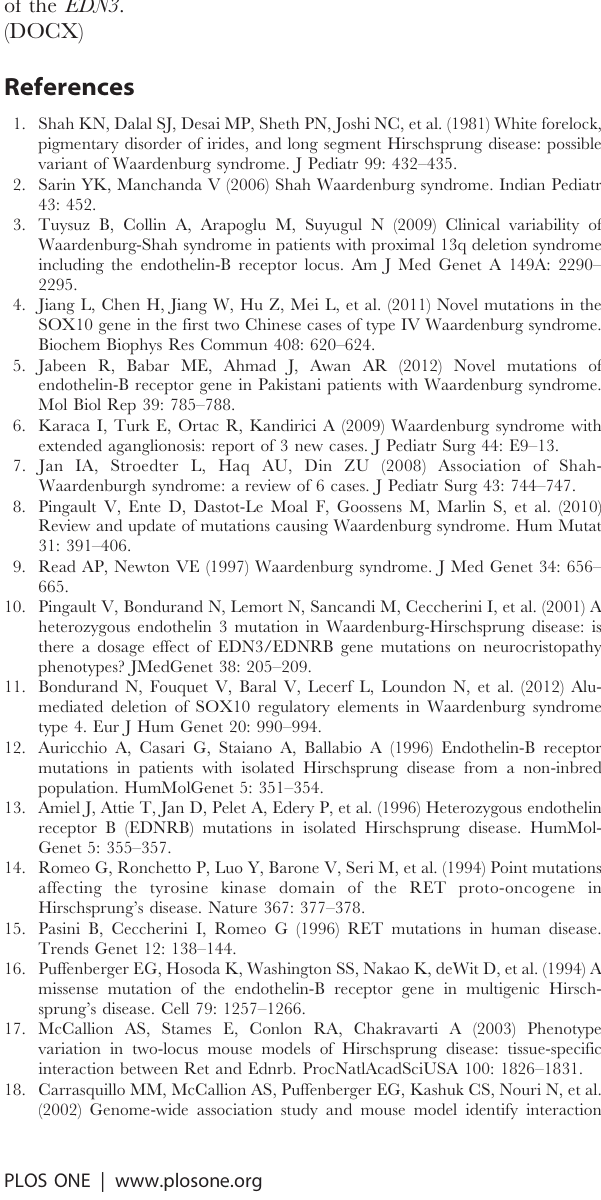
Table S1 TargetP 1.1 server prediction results. Subcel- lular locations of different EDNRB isoform proteins were predicted by using TargetP 1.1 server. SP , a signal peptide; mTP , a mitochondrial targeting peptide; M , Mitochondrion; S , Secretory pathway; RC : Reliability class, from 1 to 5, where 1 indicates the strongest prediction. Table S2 Genes disrupted by CNVs in II-5. Table S3 Non-genic regions disrupted by CNVs in